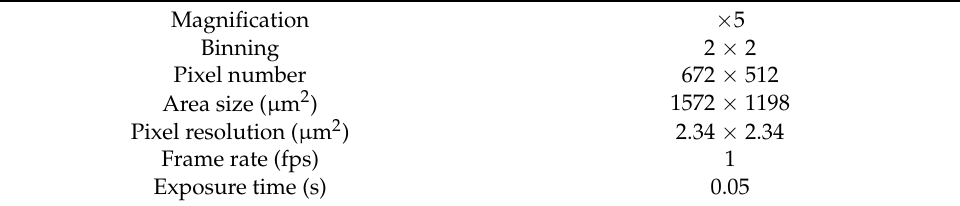
Table 2. Image-capturing